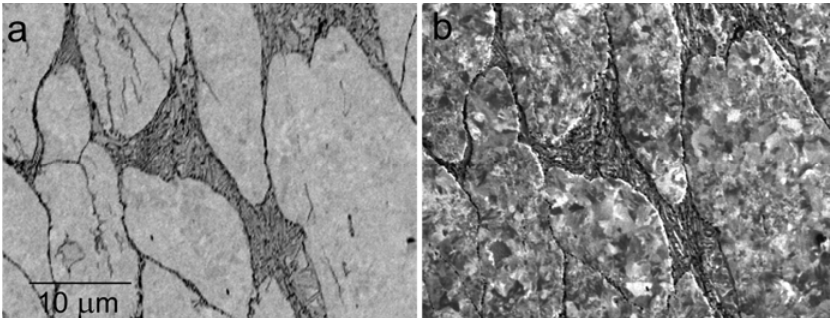
Figure 16. The X210Cr12 steel processed with the semi-solid technology (see Figure 15) and annealed at 500  C for 60 min. ( a ) Standard BSE image at 8 keV; ( b ) Sample immersed in 900 V/mm, landing energy 500